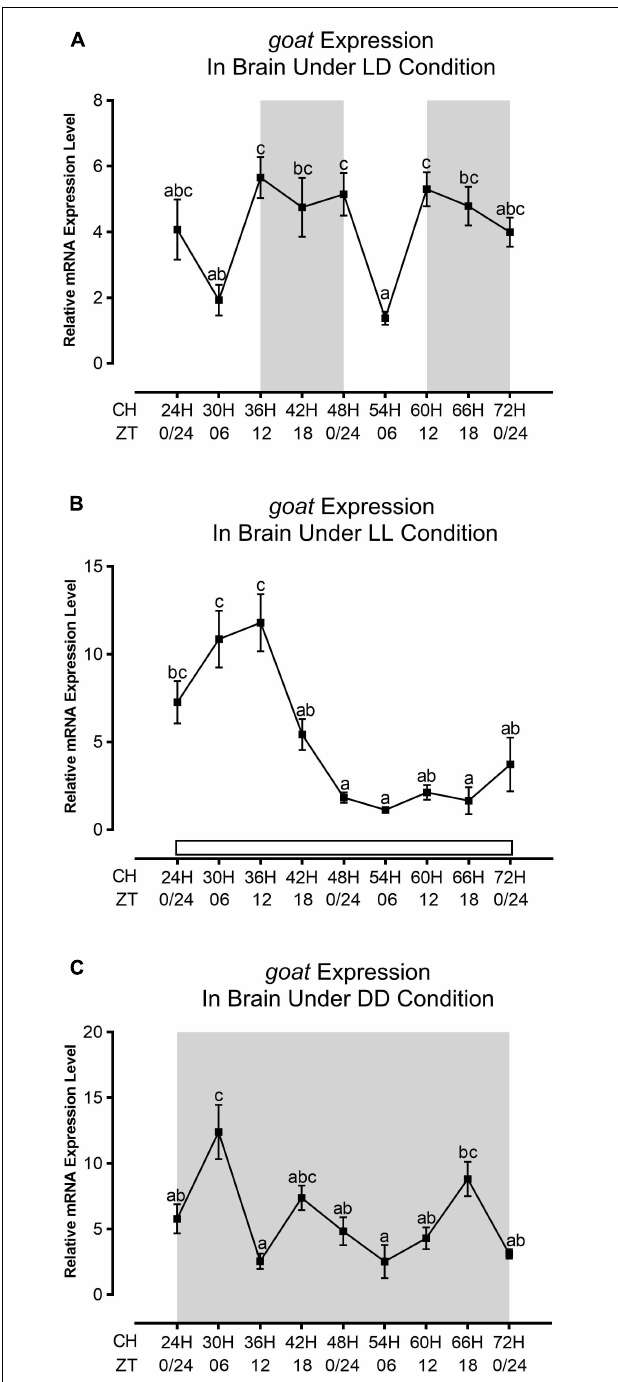
FIGURE 3 | Daily expression profile of goat gene under different photic conditions (LD, LL, and DD) in the brain of zebrafish. The daily expression profile of goat mRNA at (A) LD, (B) LL, and (C) DD. The relative quantification values in the graph are shown as the mean ± SEM ( n = 3). Different letters indicate significant differences evaluated by one-way ANOVA [ (A) F (8,18) = 5.743, p = 0.001, (B) F (8,18) = 13.813, p = 0.000, and (C) F (8,18) = 8.109, p = 0.000] followed by post-hoc Tukey’s test ( p < 0.05). The gray background resembles the dark phase and the white background is for the light phase. CH and ZT in the x -axis stand for Clock Hour and Zeitgeber Time,